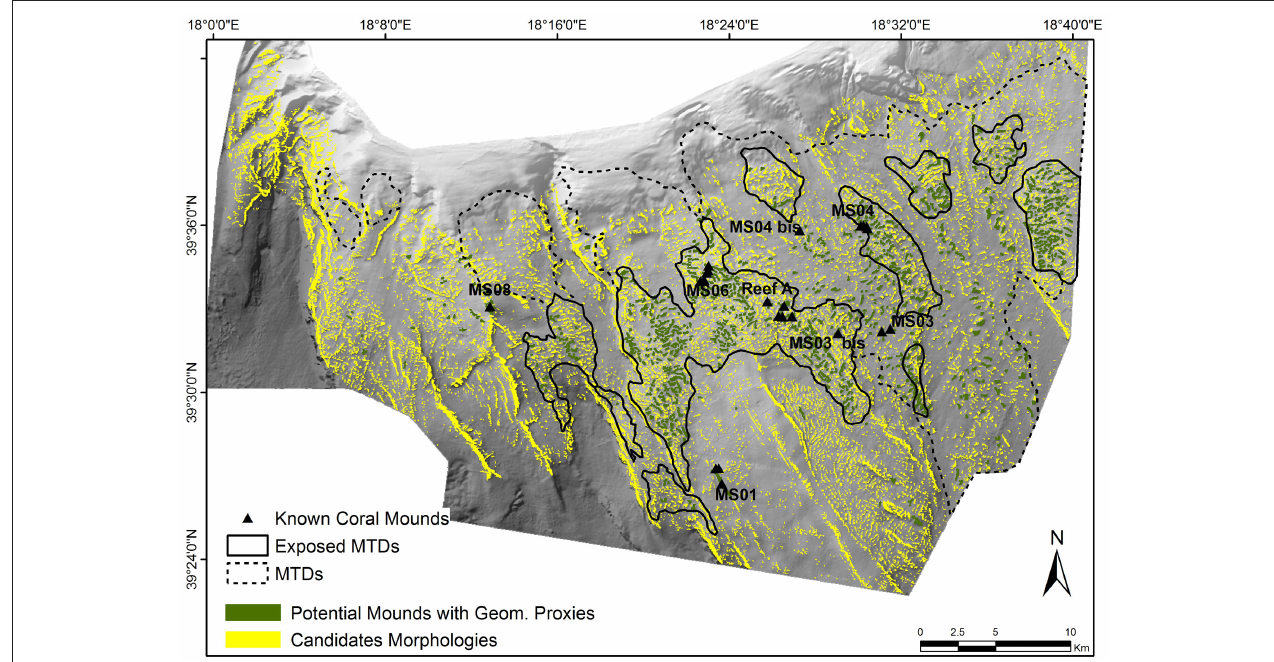
FIGURE 4 | Distribution map of two sets of mound-like features in the SML Province: In yellow the 7,447 candidate morphologies [BPI (3 pixels) > 1] and in green the 736 potential coral mounds identified with the Geomorphometric proxies method.